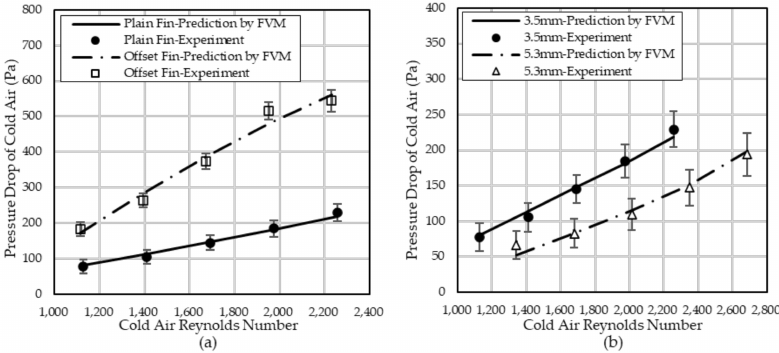
Figure 8. Experimental and numerical comparison of the pressure drop across the plate-fin heat exchanger, ( a ) with plain and o ff set strip fins and ( b ) with 3.5 and 5.3 mm fin